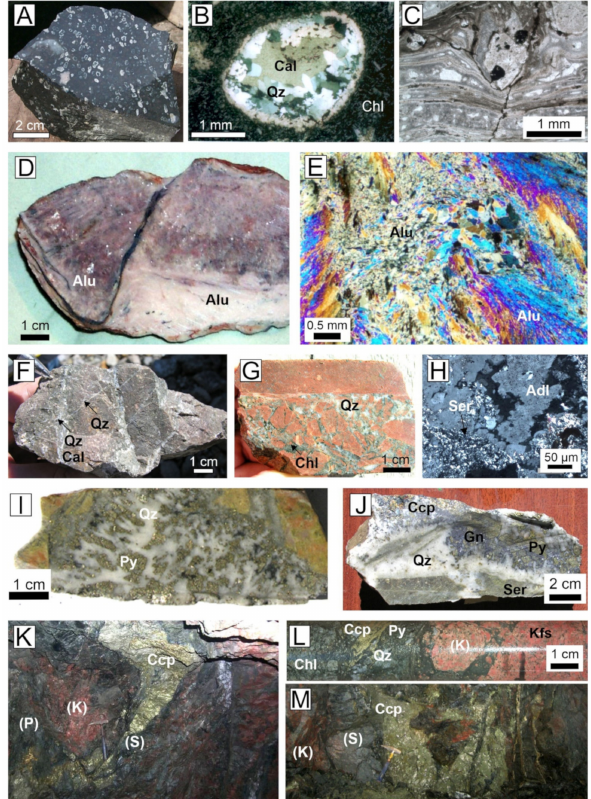
Figure 4. Aspects of the gold-(polymetallic) deposits of the TMP and their host rocks. ( A ) Amyg- daloidal andesite with propylitic hydrothermal alteration form outer zones of the Botica Velha (V3) high-sulfidation gold mineralization; ( B ) Detail of an amygdule in ( A ) e, filled by quartz druses and later calcite, showing the very well-preserved state of volcanic rocks from the TMP; ( C ) Laminated rhyolitic tuff (transmitted light; parallel polarizers); ( D ) Pink coarse-grained alunite branching vein and later white, fine-grained alunite; ( E ) Detail of (d), showing the coarse-grained alunite branching replaced by fine-grained alunite (transmitted light; crossed polarizers); ( F ) Porphyritic rhyolite that hosts the Coringa low- to intermediate-sulfidation mineralization crosscut by quartz and calcite vein- lets; ( G ) Rhyolite cut by hydrothermal breccia vein cemented by quartz, chlorite and small amounts of pyrite (Coringa deposit); ( H ) Adularia that replaced igneous feldspar crystals from adularia–sericite halo associated with the Coringa gold-polymetallic mineralization. Note the dissolution vugs of igneous feldspar replaced by adularia and well-formed small druses of adularia; ( I ) Gold-mineralized epithermal quartz–pyrite vein of the Coringa deposit; ( J ) Gold-mineralized epithermal quartz–pyrite– galena–chalcopyrite vein of the Coringa deposit; ( K ) Deformed massive gold-rich chalcopyrite vein with associated pyrite and minor bornite hosted by the Palito Granite affected by potassic (strong red-color), propylitic and sericitic alteration; ( L ) Hydrothermal breccia with a quartz–sulfide–chlorite matrix (dark-colors) and rounded fragments and veinlets of chalcopyrite, hosted by the potassic altered Palito Granite. Note quartz–sulfide gold mineralized vein; ( M ) Sulfide-rich sulfide zones from the Palito Au–(Cu) porphyry deposit. Mineral abbreviation after [92]. (K) = potassic alteration; (S) = sericitic alteration; (P) = propylitic